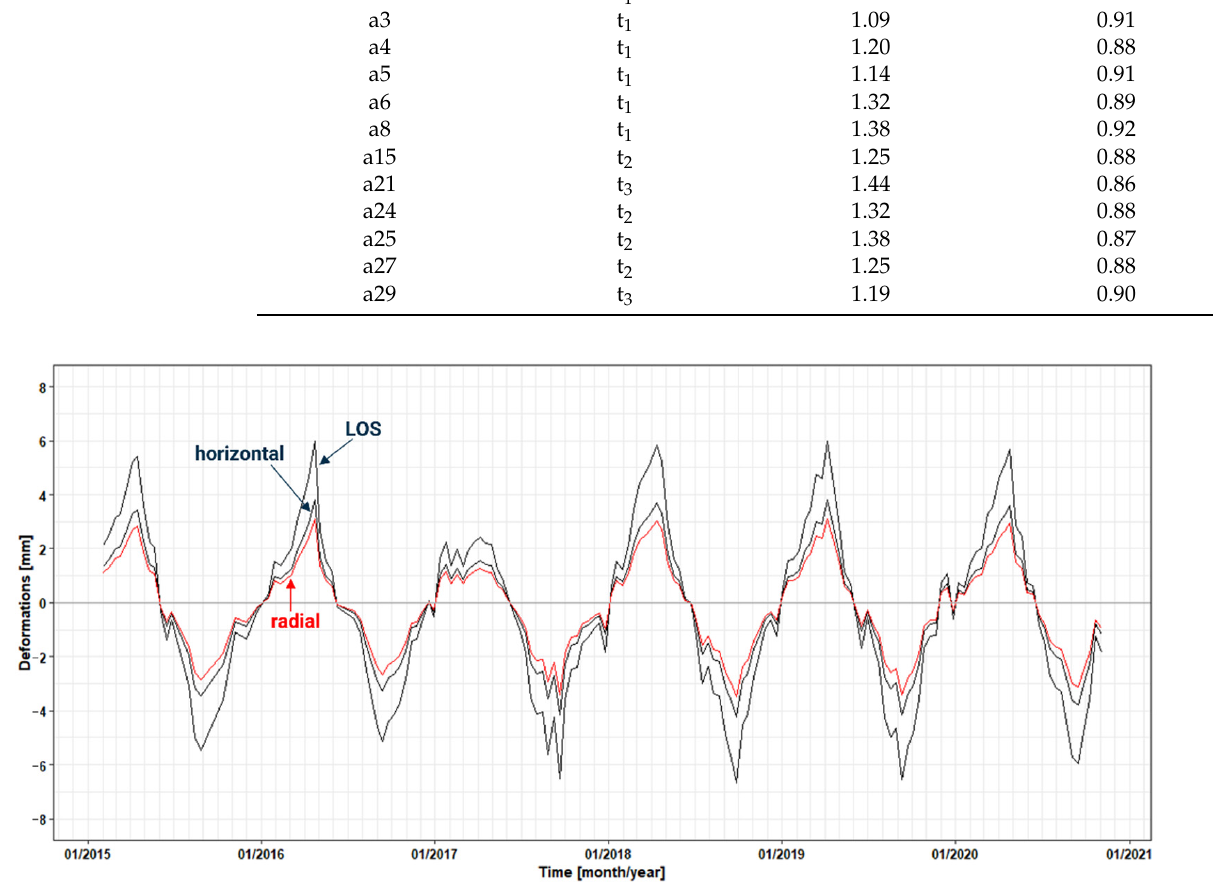
Figure 7. The seasonal pattern of the PSI measurement, as well as the water level, are similar to each other. This connection is confirmed by an r 2 of 0.56. Therefore, it is evident that the water level